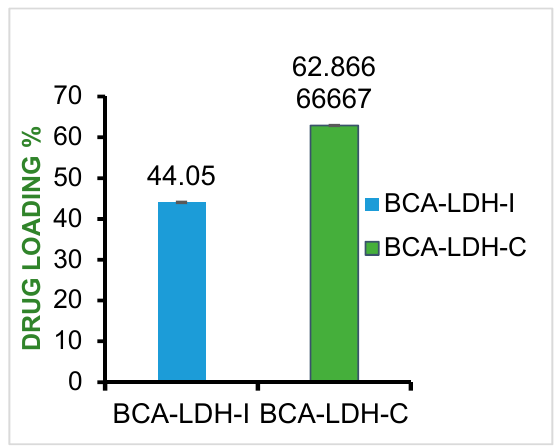
Figure 12. BCA loading percentage in BCA-LDH-I and BCA-LDH-C.